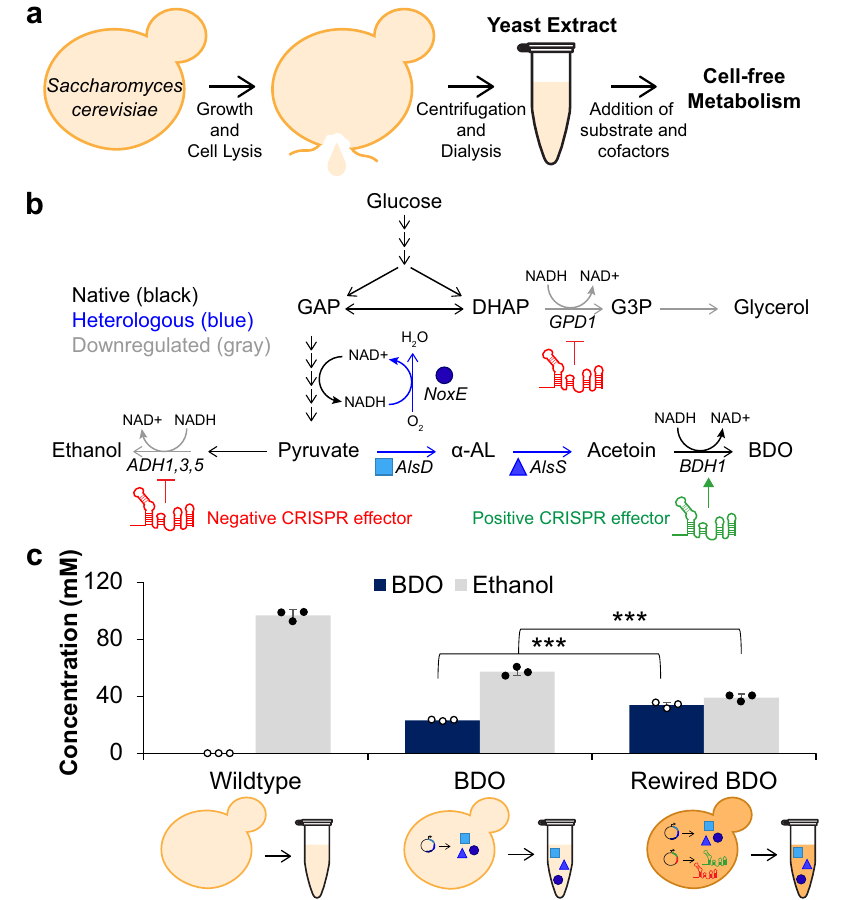
Fig. 1 Metabolic rewiring in vivo is re fl ected in cell extracts. a Schematic overview of yeast cell extract preparation for cell-free reactions. b Metabolic map showing wild-type yeast metabolism in black, heterologous enzymes for BDO strains in blue, and CRISPR effectors expressed by rewired BDO strain. c Initial cell-free comparison of wildtype, BDO, and rewired BDO cell extracts converting glucose to native and heterologous metabolites. Extract from the metabolically rewired BDO strain produces more BDO and less ethanol than extract from the unmodi fi ed BDO strain (*** p = 0.001 as determined by a two- tailed Student ’ s t -test). Data represent mean ± standard deviation of n = 3 technical replicates. Source data are provided as a Source Data fi